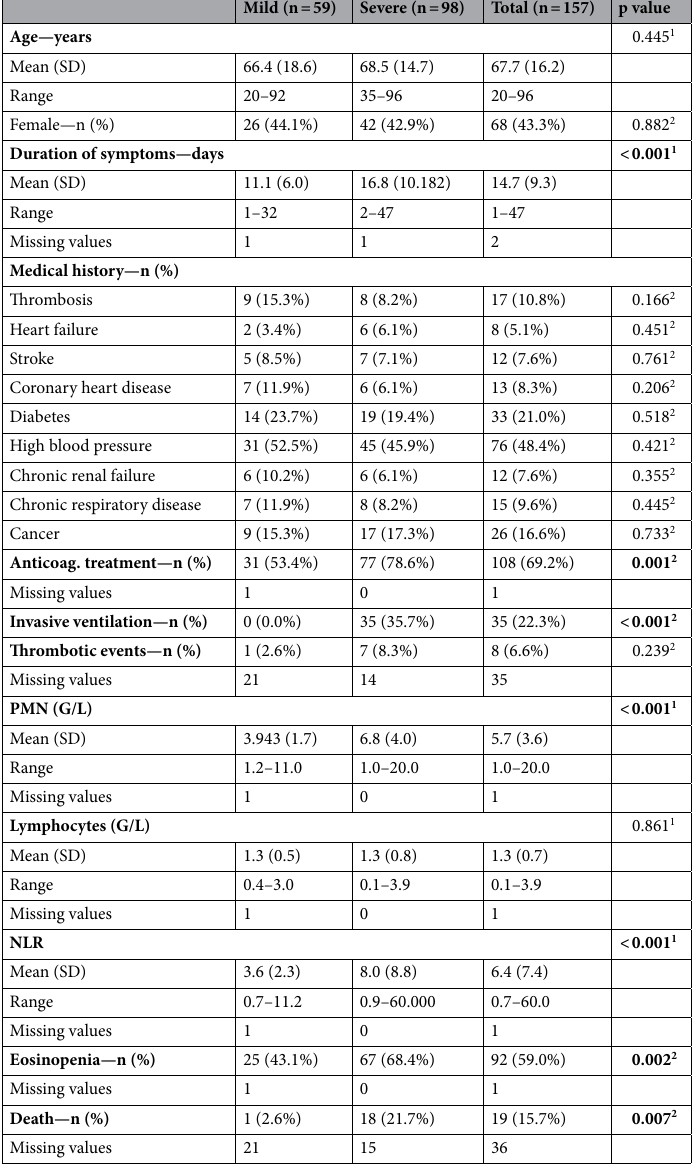
Table 1. Patients with COVID-19 characteristics. PMN polymorphonuclear neutrophils, NLR neutrophil– lymphocyte ratio, 1 Student’s t test, 2 Pearson’s Chi-squared